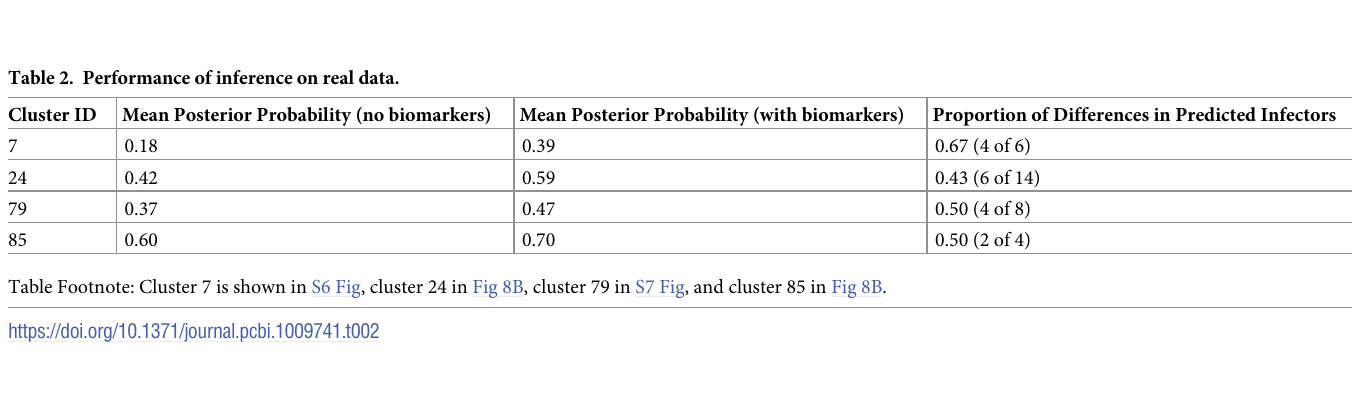
Table 2. Performance of inference on real data.